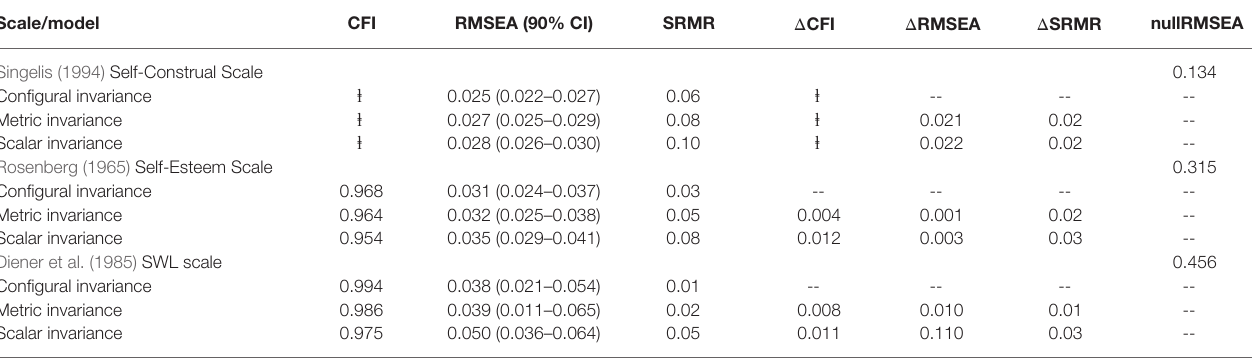
TABLE 1 | Tests of measurement invariance for the scales in Study